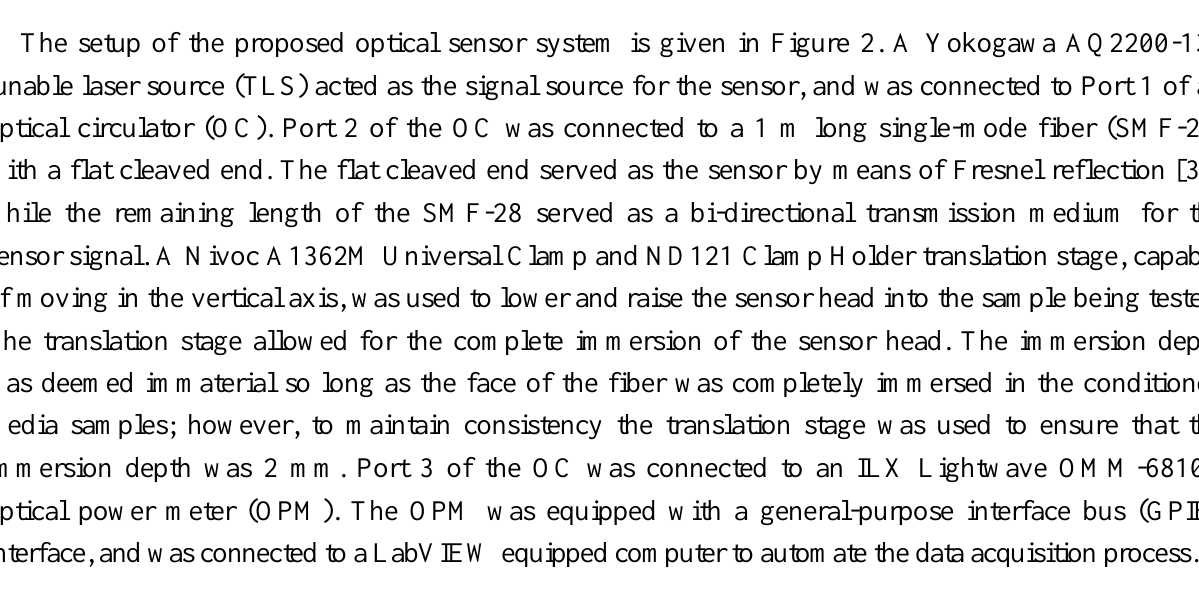
Figure 2. Experimental setup of the proposed sensor